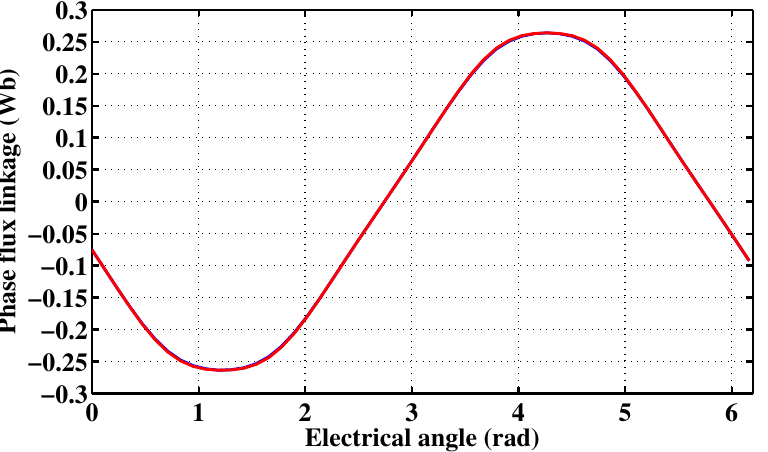
Figure 12. Phase flux linkages versus electrical angle. Legend: (red) proposed armature winding arrangement, (blue) conventional armature winding